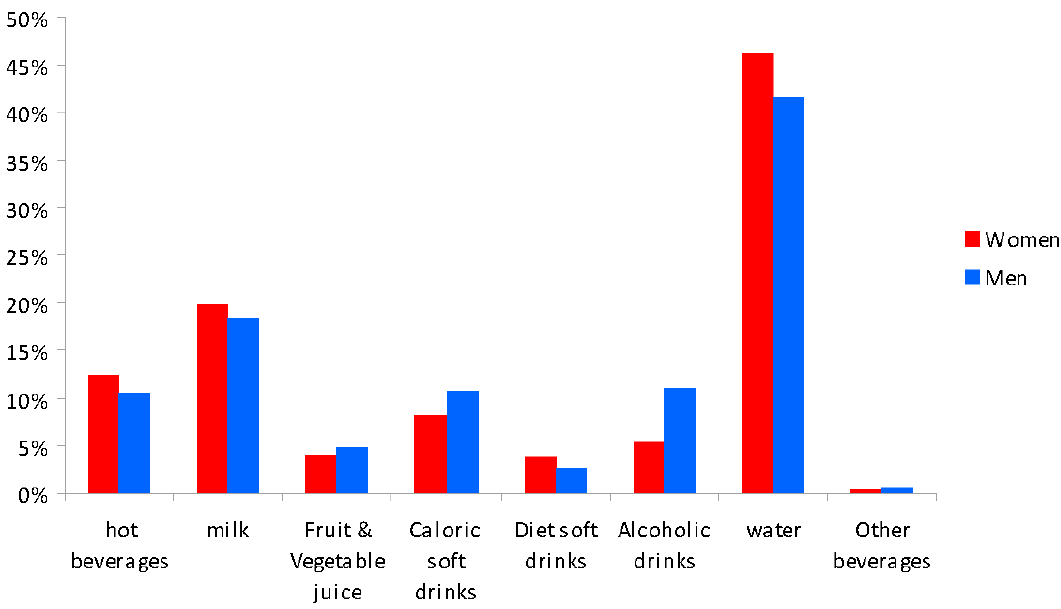
Figure 2. Percentage of beverages consumed over a three ‐ day period by gender.